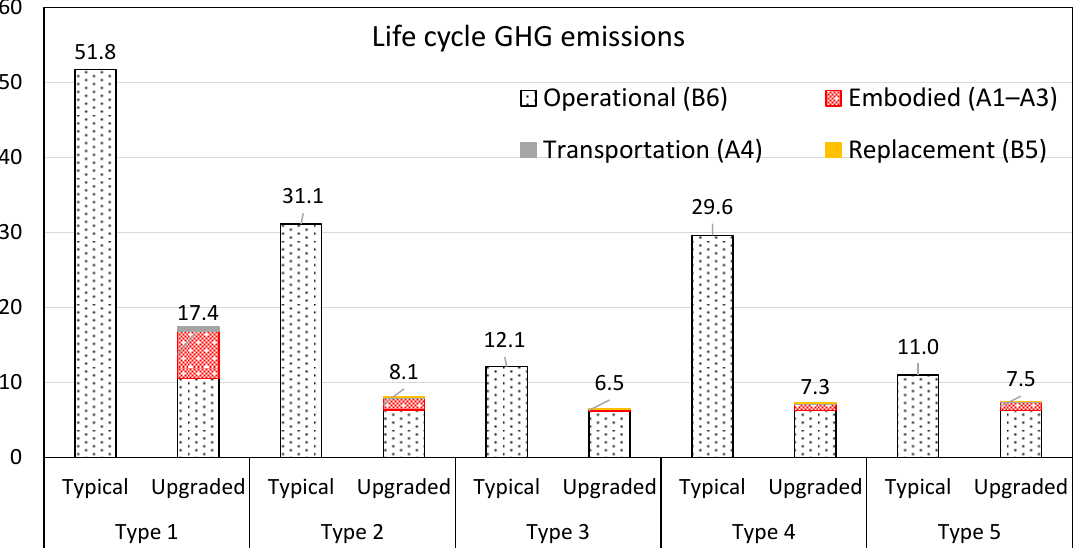
Figure 4. Comparison of lifecycle GHG emissions of prototype buildings .